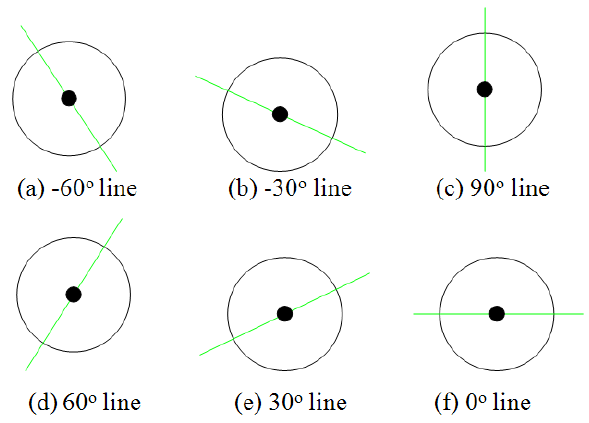
Figure 17. Accuracy and robustness testing